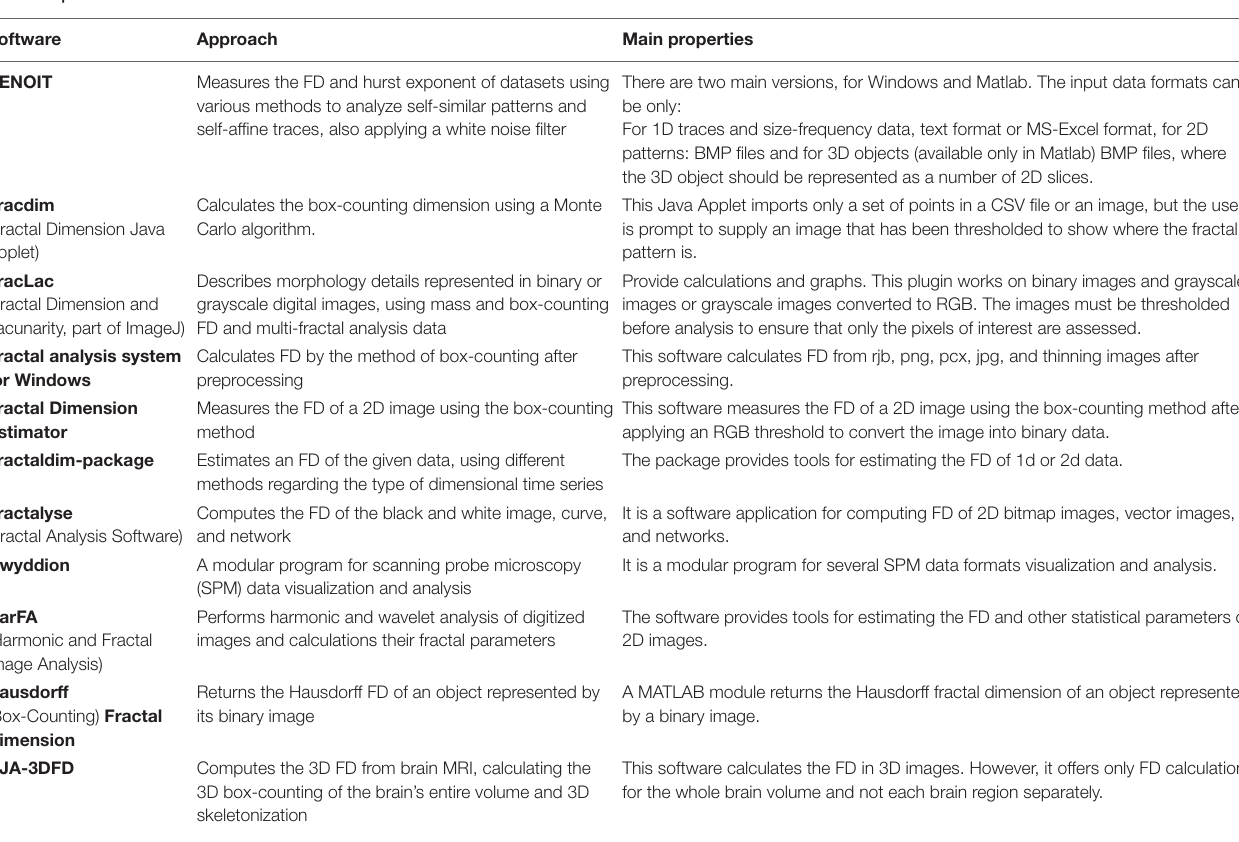
FIGURE 2 | Visualization of computing fractal dimension (FD). TABLE 1 | Fractal dimension calculation